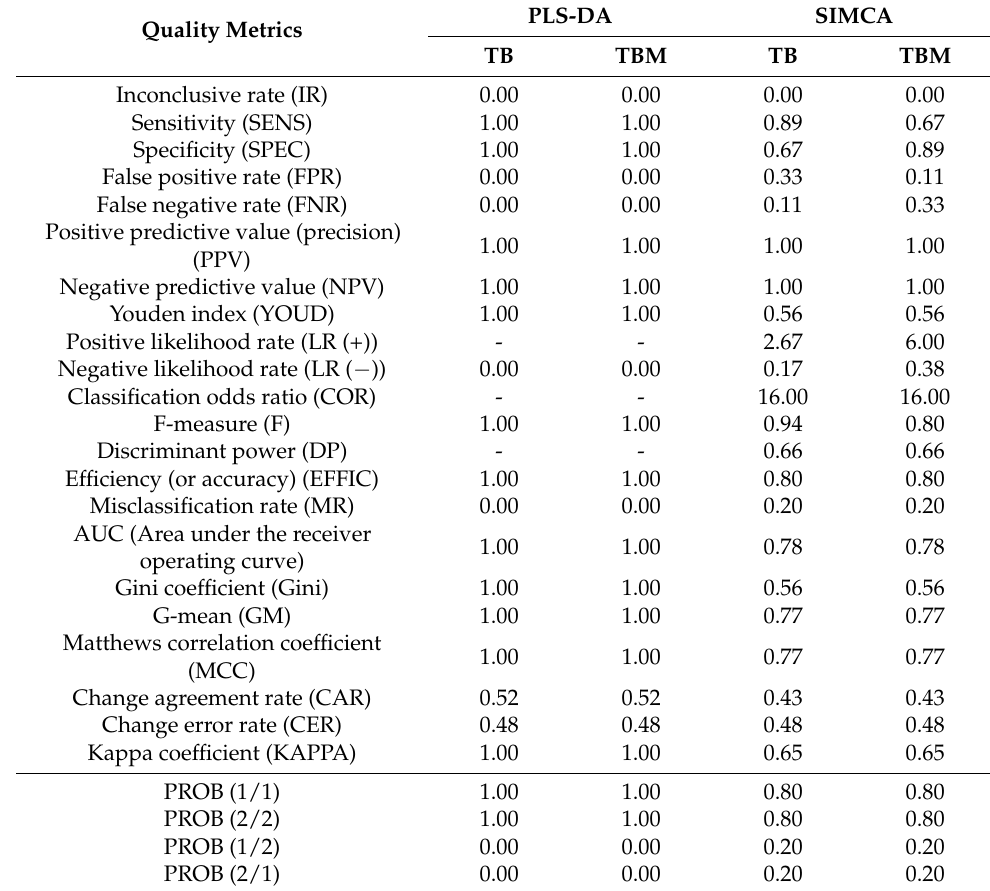
Table 4. Quality performance metrics (QPM) summary chart of the selected